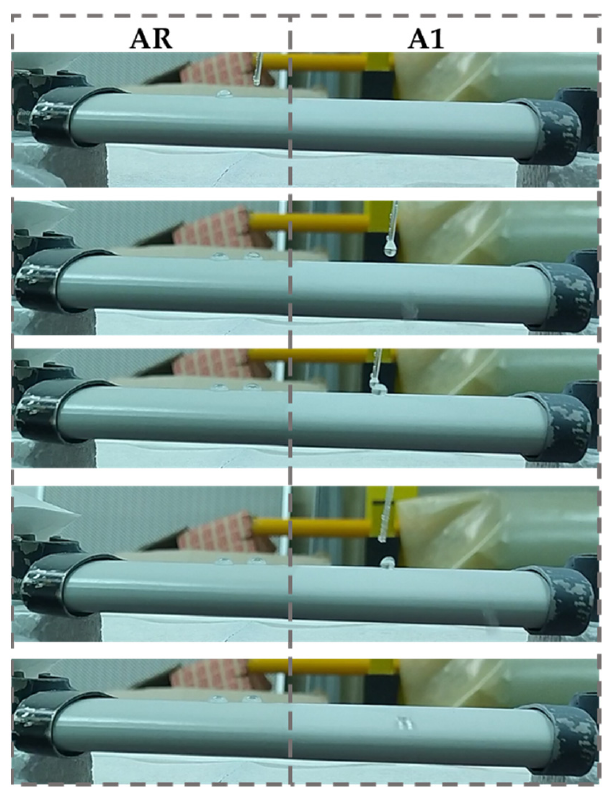
Figure 6. Images sequences of water droplets dropping on AR ( left ) and A1 ( right ) surfaces.